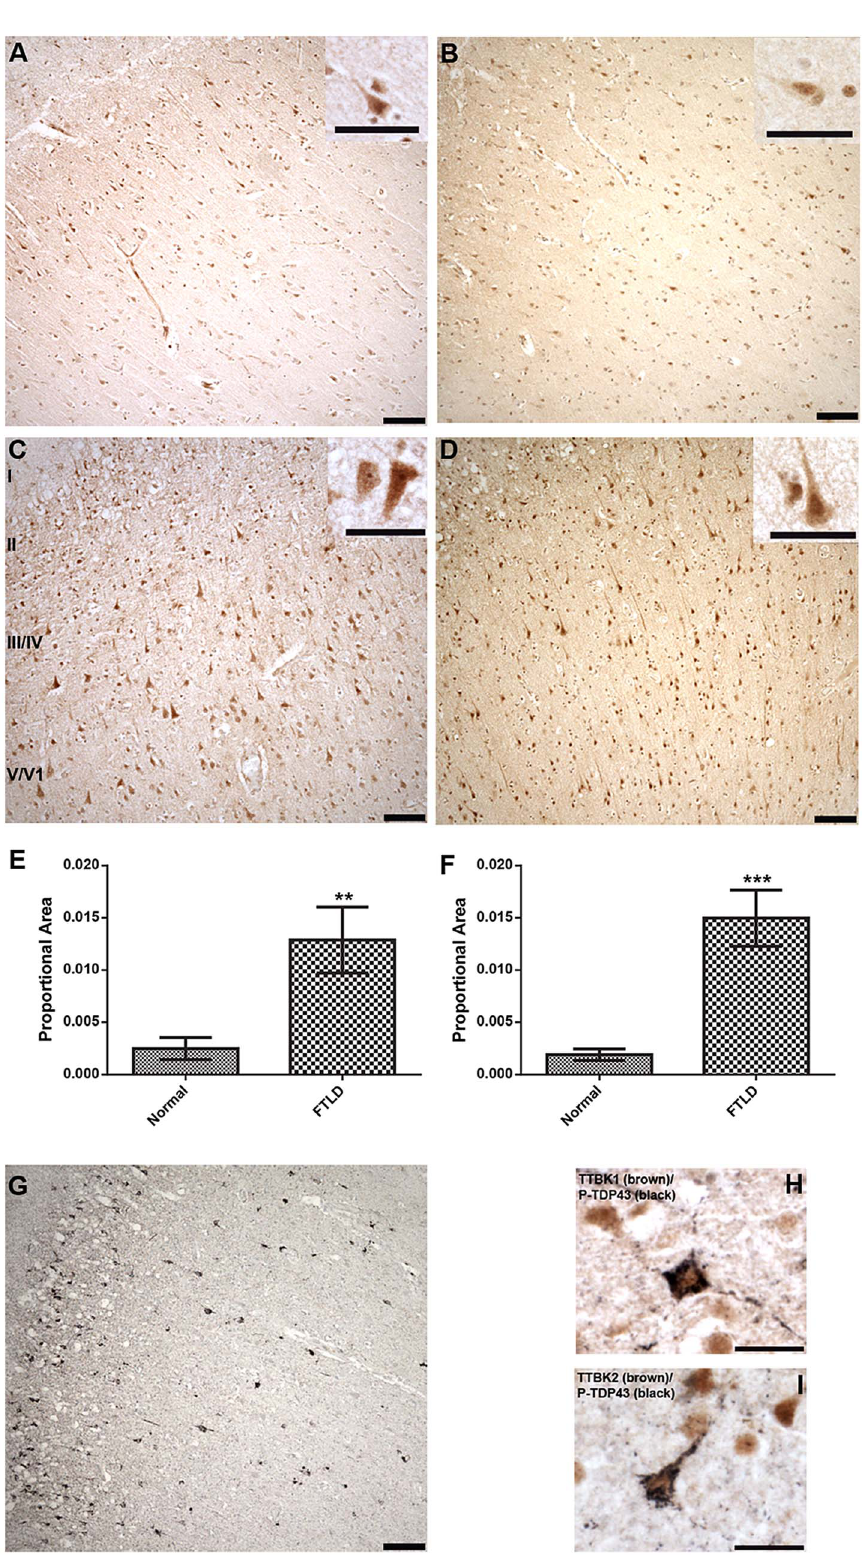
Figure 4. Upregulated Tau tubulin kinases are also co-expressed with phospho-TDP-43 pathology. Representative photomicrographs depicting TTBK1 (A, C) and TTBK2 (B, D) immunoreactivity in cortical neurons in normal (A, B) and FTLD-TDP Type B (C, D) cases. The cellular distribution is both cytoplasmic and nuclear (insets), and immunoreactivity appears to be more widespread in FTLD cases relative to normal controls. Cortical layers I-VI are indicated (C). Quantification of immunostaining demonstrated a statistically significant increase in both TTBK1 (E) and TTBK2 (F) in FTLD cases compared to normal controls (** P =0.003; *** P , 0.0001). The distribution of phospho-TDP-43 immunoreactivity in the cortex of an FTLD